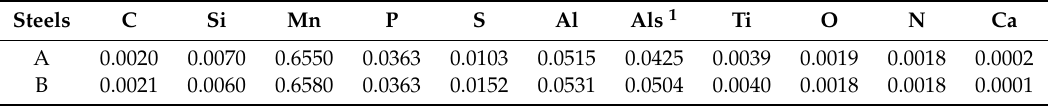
Table 1. Chemical compositions of the steels